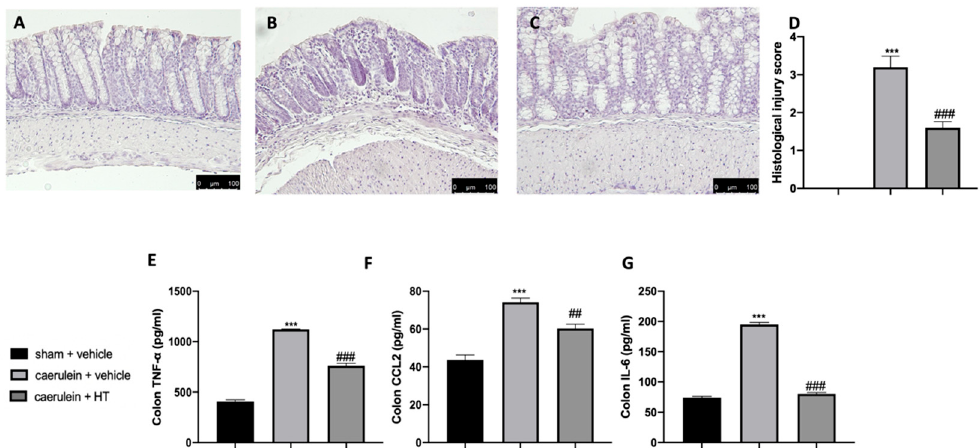
Figure 5. Hydroxytyrosol (HT) effect on colon inflammation: colon histological analysis: sham + vehicle ( A ), caerulein + vehicle ( B ), caerulein + HT( C ), histological injury score ( D ), colon cytokine expression: tumor necrosis factor alpha (TNF- α ) ( E ), monocyte chemotactic protein-1 (MCP1/CCL2) ( F ), interleukin 6 (IL-6) ( G ). For the analyses, n = 5 animals from each group were employed. A p -value < 0.05 was considered significant. ## p < 0.01 vs. caerulein + vehicle, *** p < 0.001 vs. sham + vehicle, ### p < 0.001 vs. caerulein + vehicle.